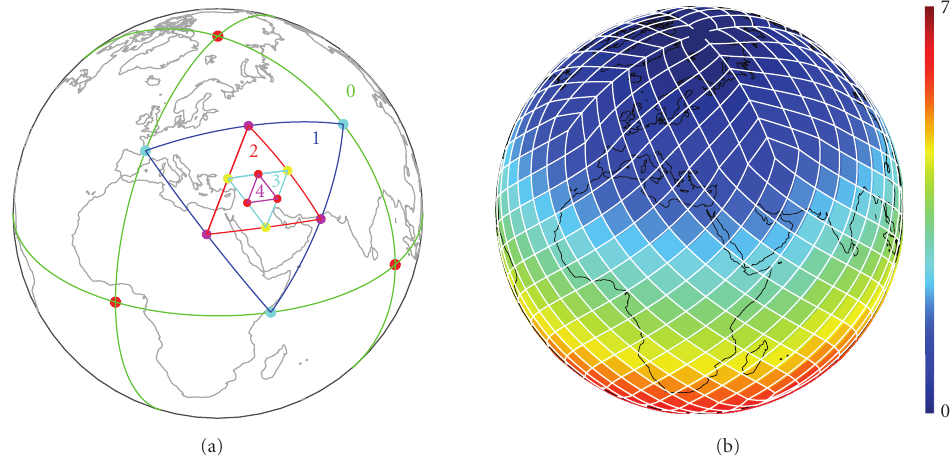
Figure 2: (a) The 8 HTM base pixels and recursive subdivisions on Earth surface. The “depth” d of the trixels is marked. (b) HEALPix tessellation at order k = 3 giving 768 pixels whose colors encode their actual IDs in the “ring”